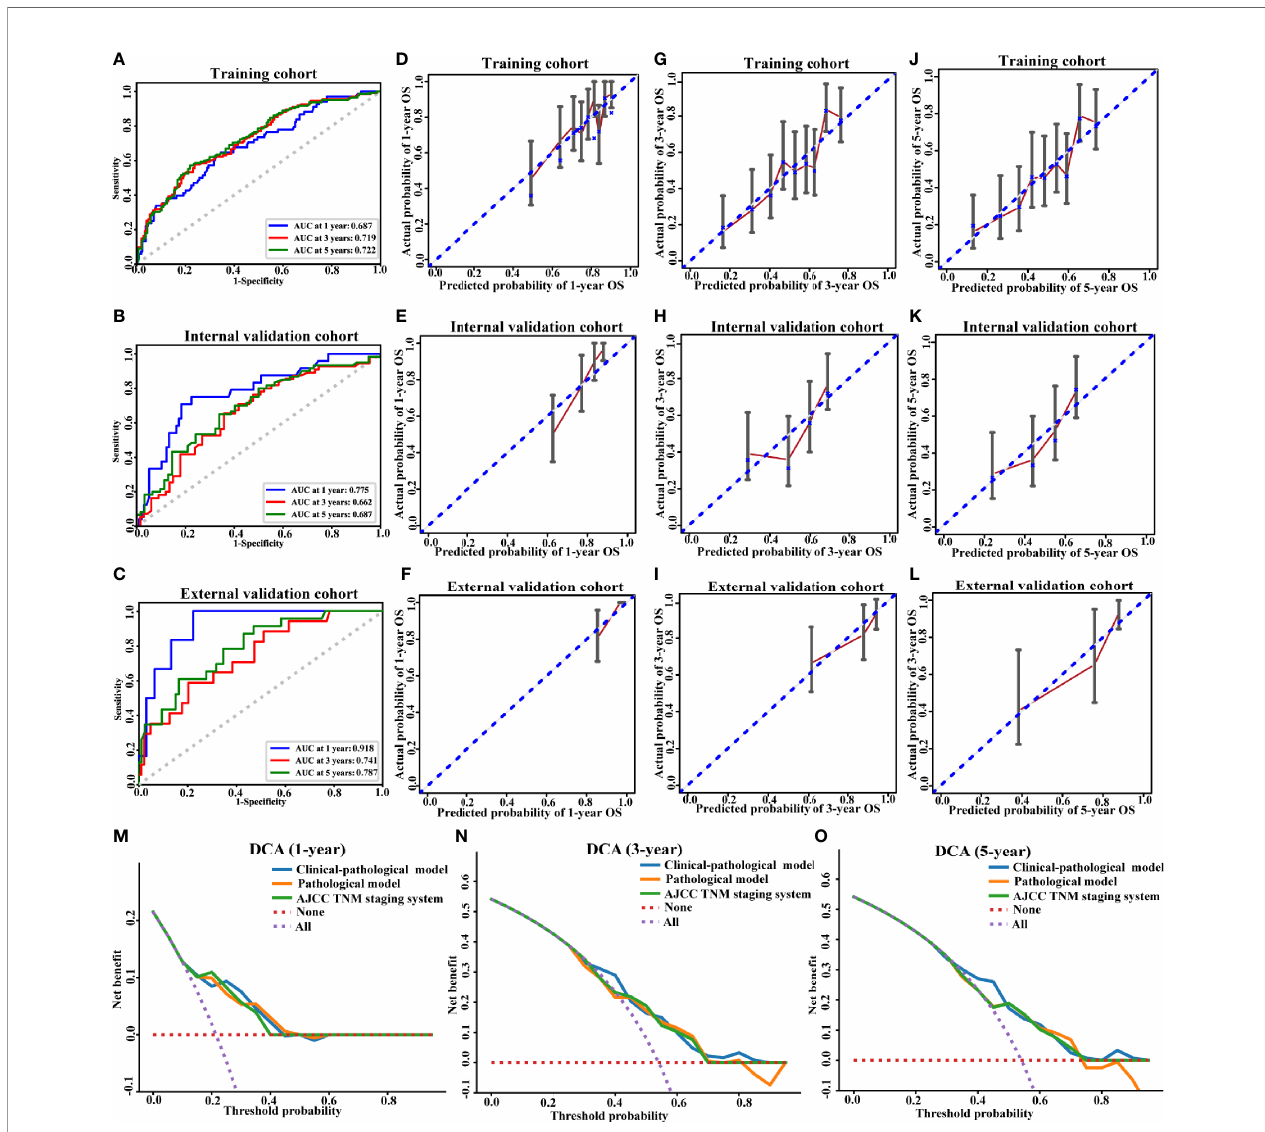
FIGURE 4 | Performance of the clinical-pathological model. ROC curve (A – C) , calibration curves for 1-year OS (D – F) , calibration curves for 3-year OS (G – I) , calibration curves for 5-year OS (J – L) , and decision curve analysis (M – O) for the training (A, D, G, J) , internal validation (B, E, H, K, M – O) and external validation cohorts (C, F, I, L) . AUC, area under the curve; OS, overall